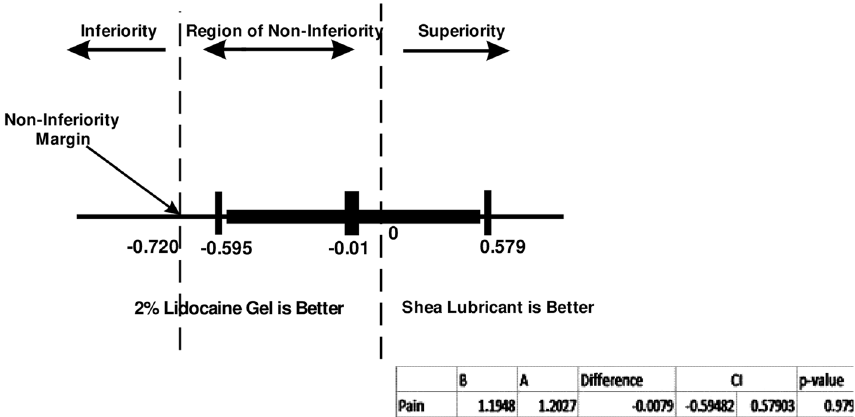
Figure 4. 95% CI for mean difference of pain during procedure and Non-inferiority (per protocol population).